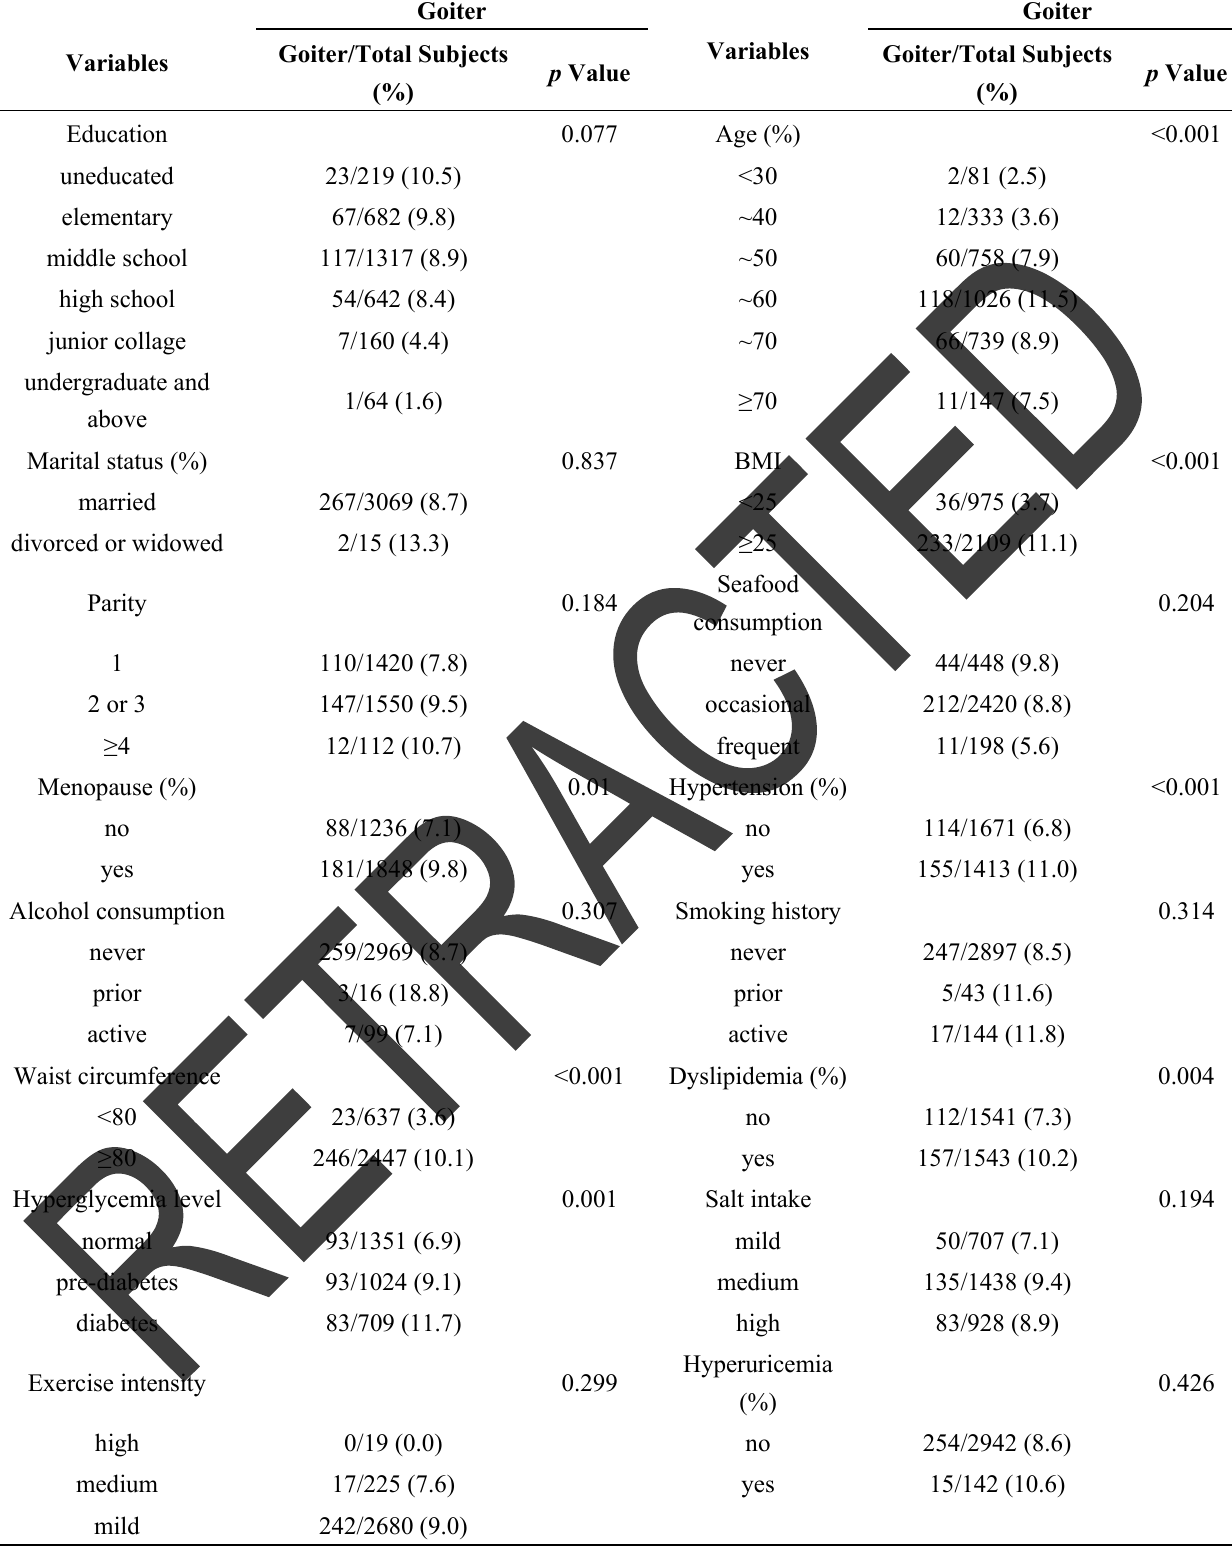
Table 2. Characteristics of the Study Population and